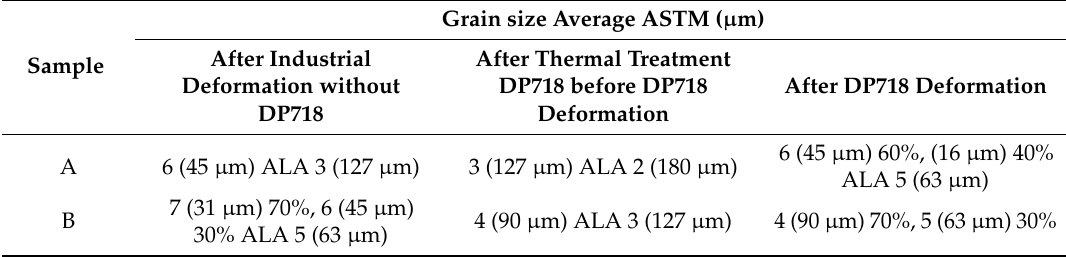
Table 1. Grain size evolution.